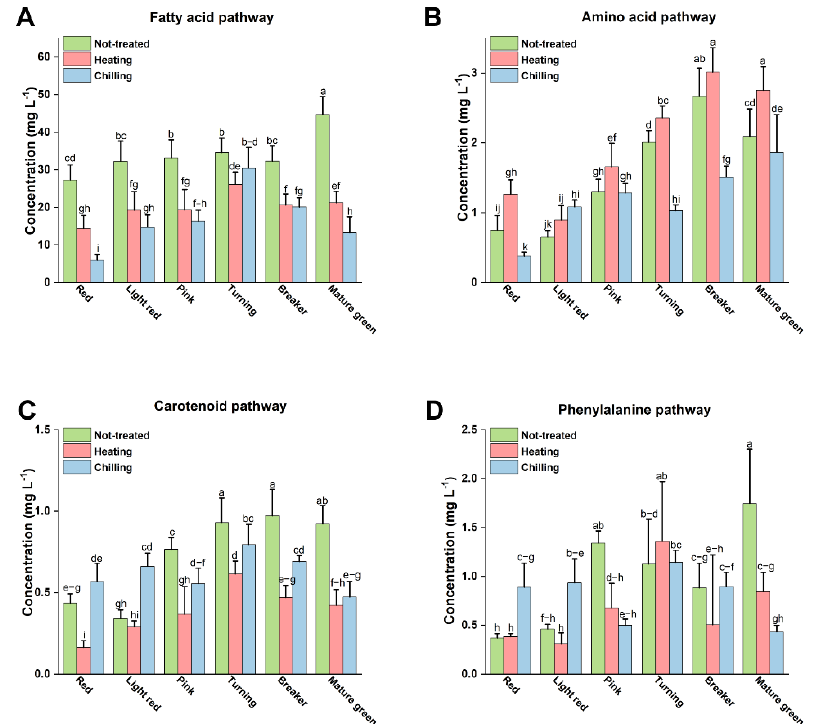
Figure 5. Effects of treatment combinations of harvest maturity and temperature on volatile concen- tration in tomatoes for aroma volatiles according to their synthesis pathway: ( A ) fatty acid pathway, ( B ) amino acid pathway, ( C ) carotenoid pathway, and ( D ) phenylalanine pathway. Each value is the mean of five replicates. Vertical bars represent standard deviation of the mean. Effect of “maturity × treatment” interaction was tested by two-way ANOVA ( p < 0.05). Different letters on the top of columns represent significantly differences between treatments using the Duncan’s multiple range test based on the interaction ( p < 0.05).